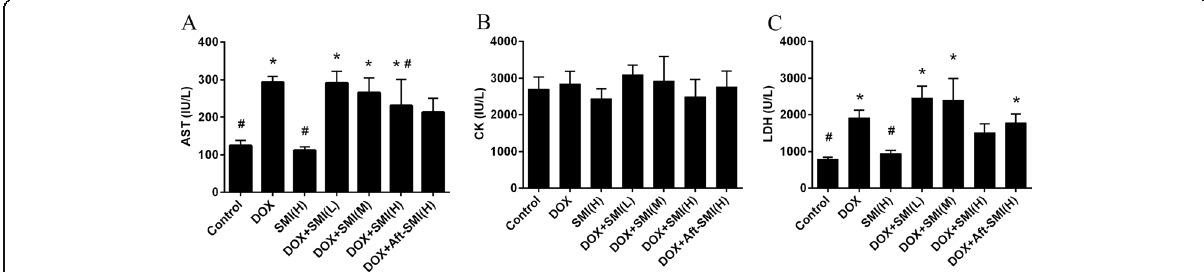
Fig. 4 Effect of treatment with SMI and/or DOX on serum levels of AST ( a ), CK ( b ) and LDH ( c ). (Means ± S.D., n = 10). *, significantly different ( P < 0.05) from respective values in the control group; #, significantly different ( P < 0.05) from respective values in the DOX